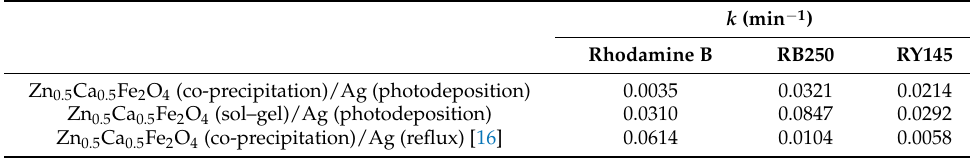
Table 3. Rate of degradation of the dyes in a pseudo-first-order